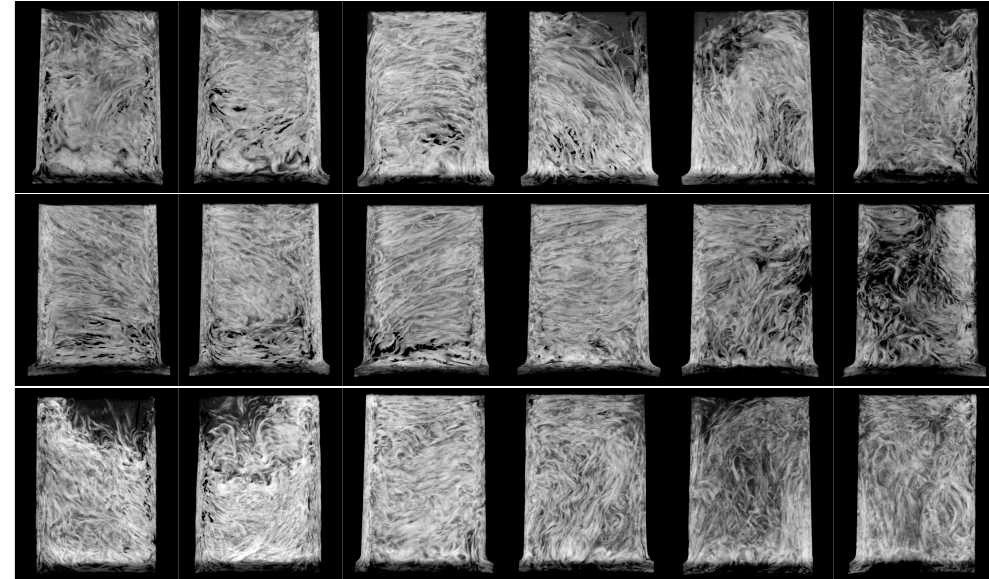
Figure 7. µCT scans of three coupons molded with Configuration A. The images in each row show the walls numbered I to VI from left to right (see Figure